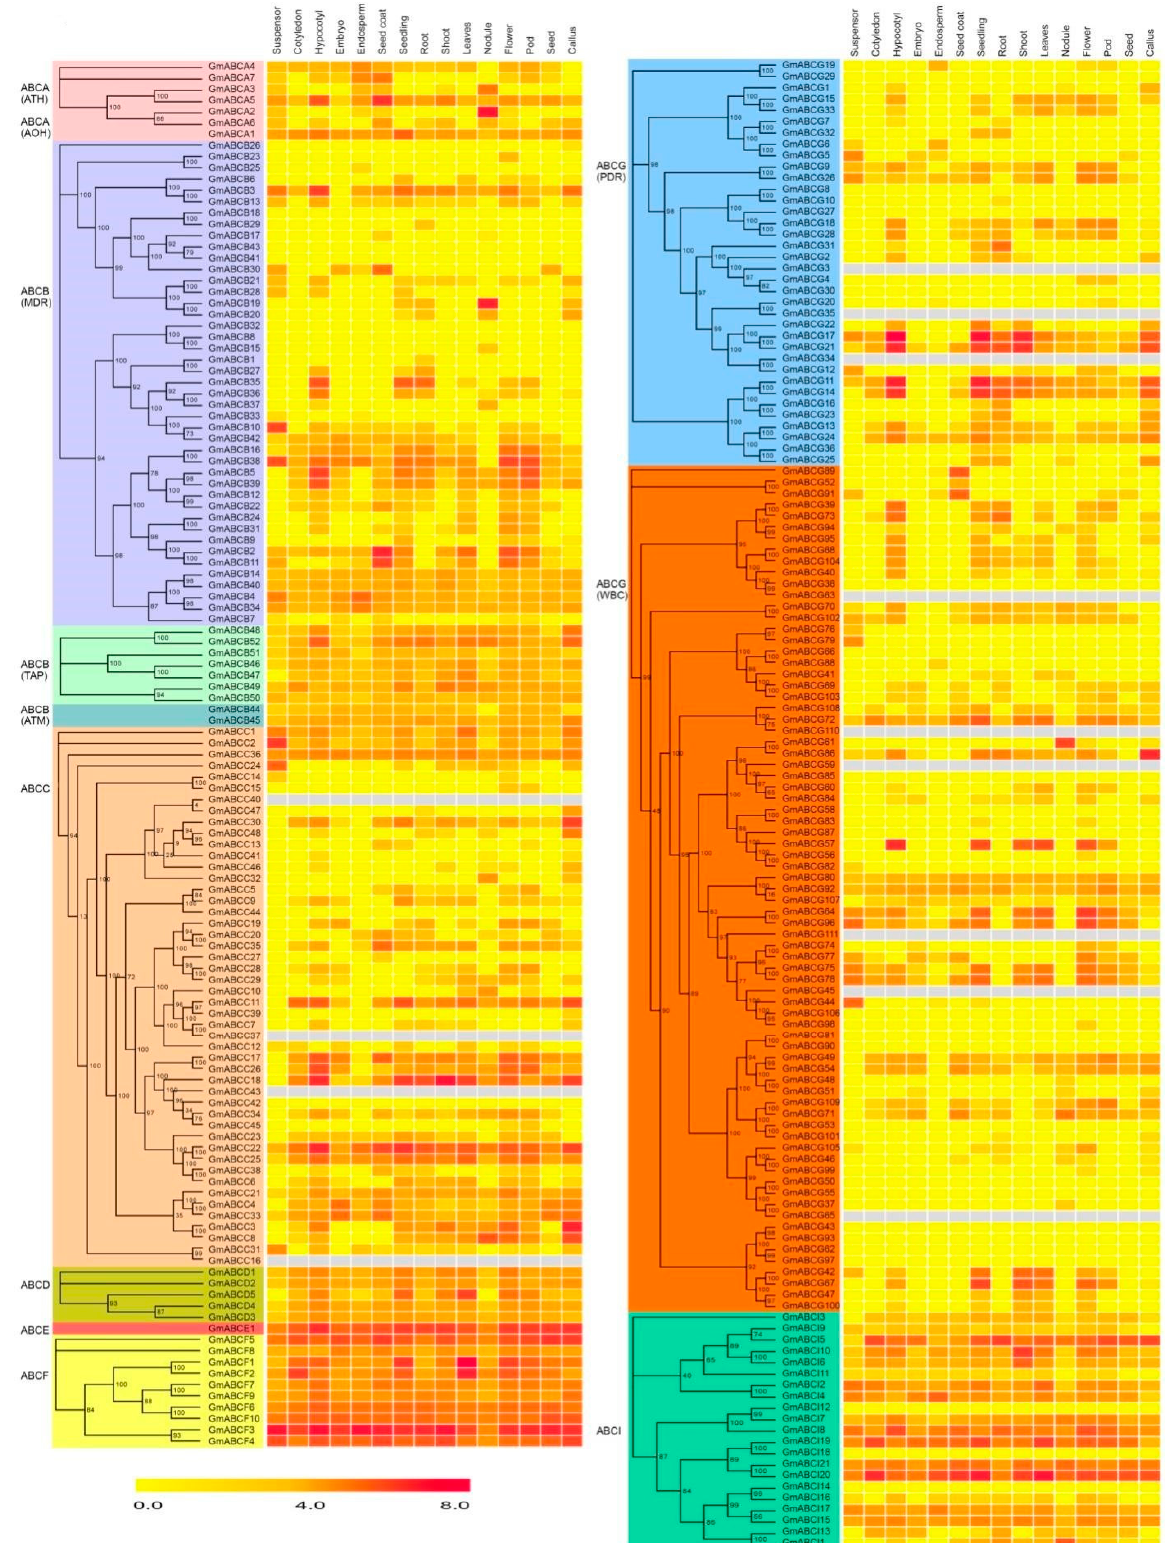
Figure 7. Expression patterns of ABC transporter genes in developmental stages and tissues of soybean. The color scale bars on the bellow display the expression levels (median log 2 (TPM+1)) of each gene. Red represents high expression levels, whereas yellow represents low expression levels.